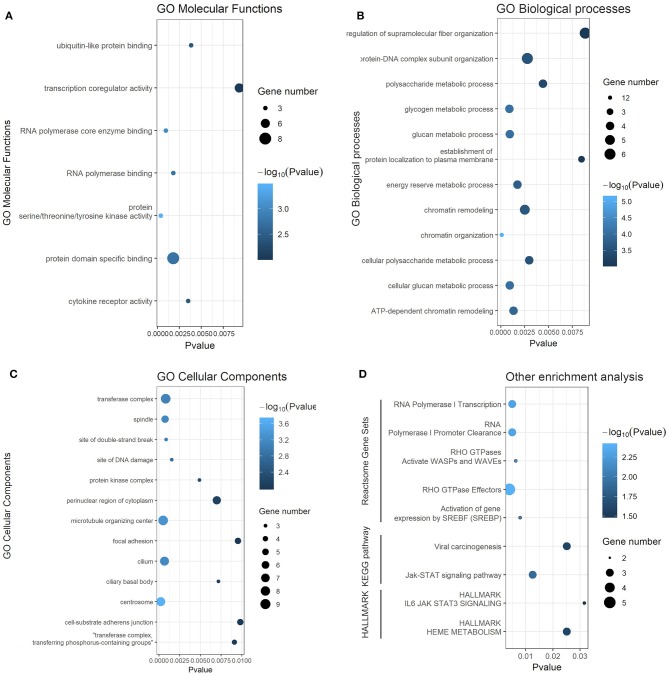
Gene ontology and KEGG pathway enrichment analysis of predicted targets of miR-622. Gene ontology (GO) annotation analysis and KEGG pathway enrichment analysis results. Each bubble represents a term, and its size represent the counts of involved genes. Lighter colors indicate smaller P-values. (A) Enriched terms of GO molecular functions (MFs, p < 0.01). (B) Enriched terms of GO biological process (BPs, p < 0.01). (C) Enriched terms of GO cellular compounds (CCs, p < 0.01). (D) Enriched terms of Reactome, KEGG pathway, and HELLMARK (p < 0.05).